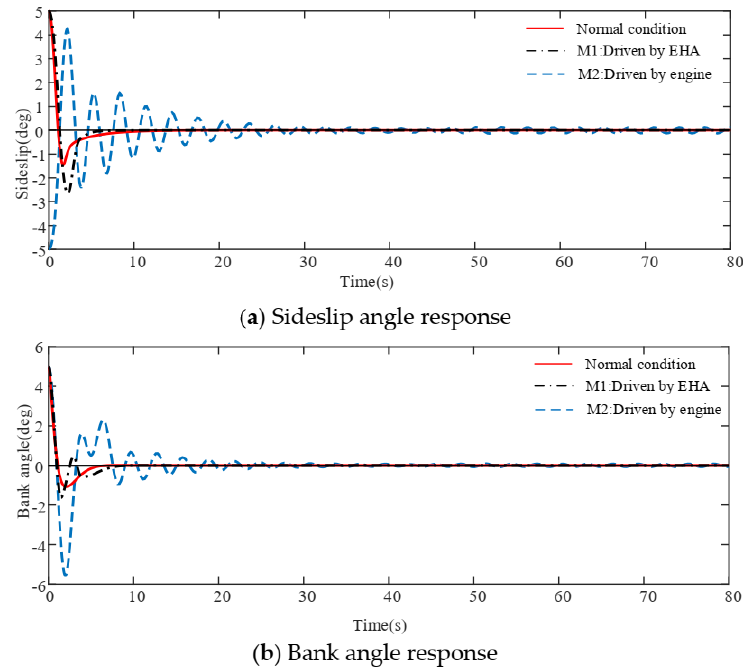
Figure 11. Recovery performance of damaged aircraft in scenario I under